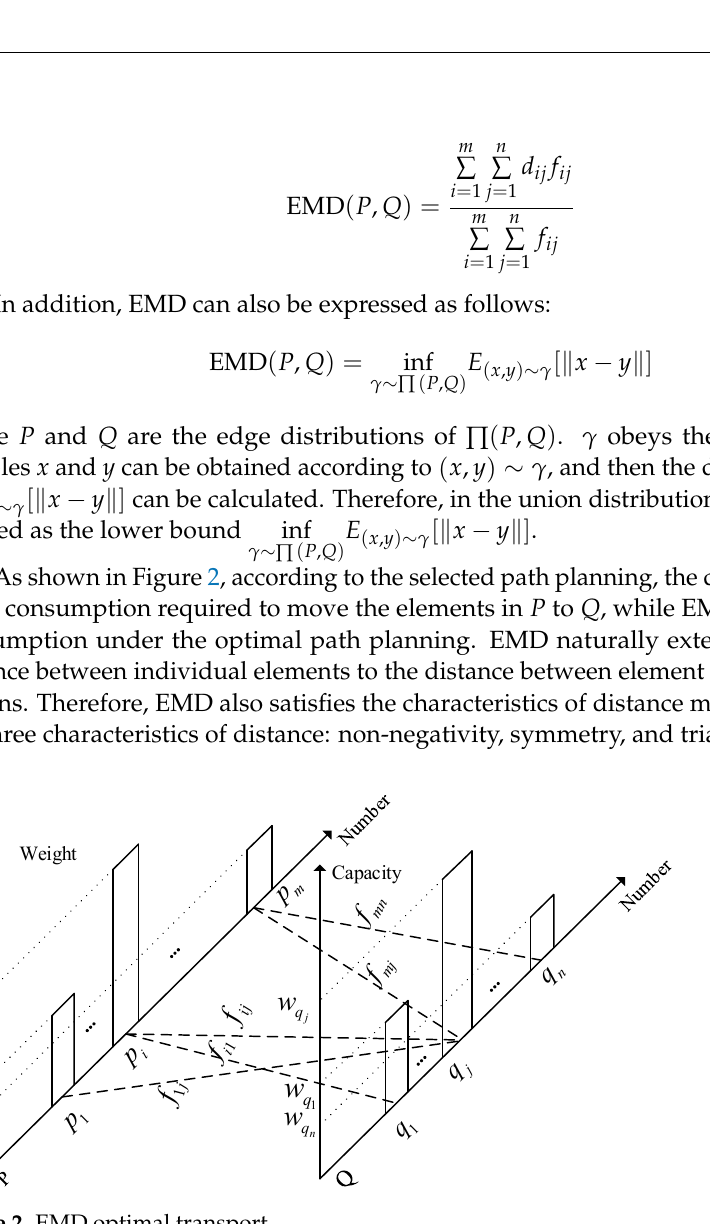
Figure 2. EMD optimal transport.